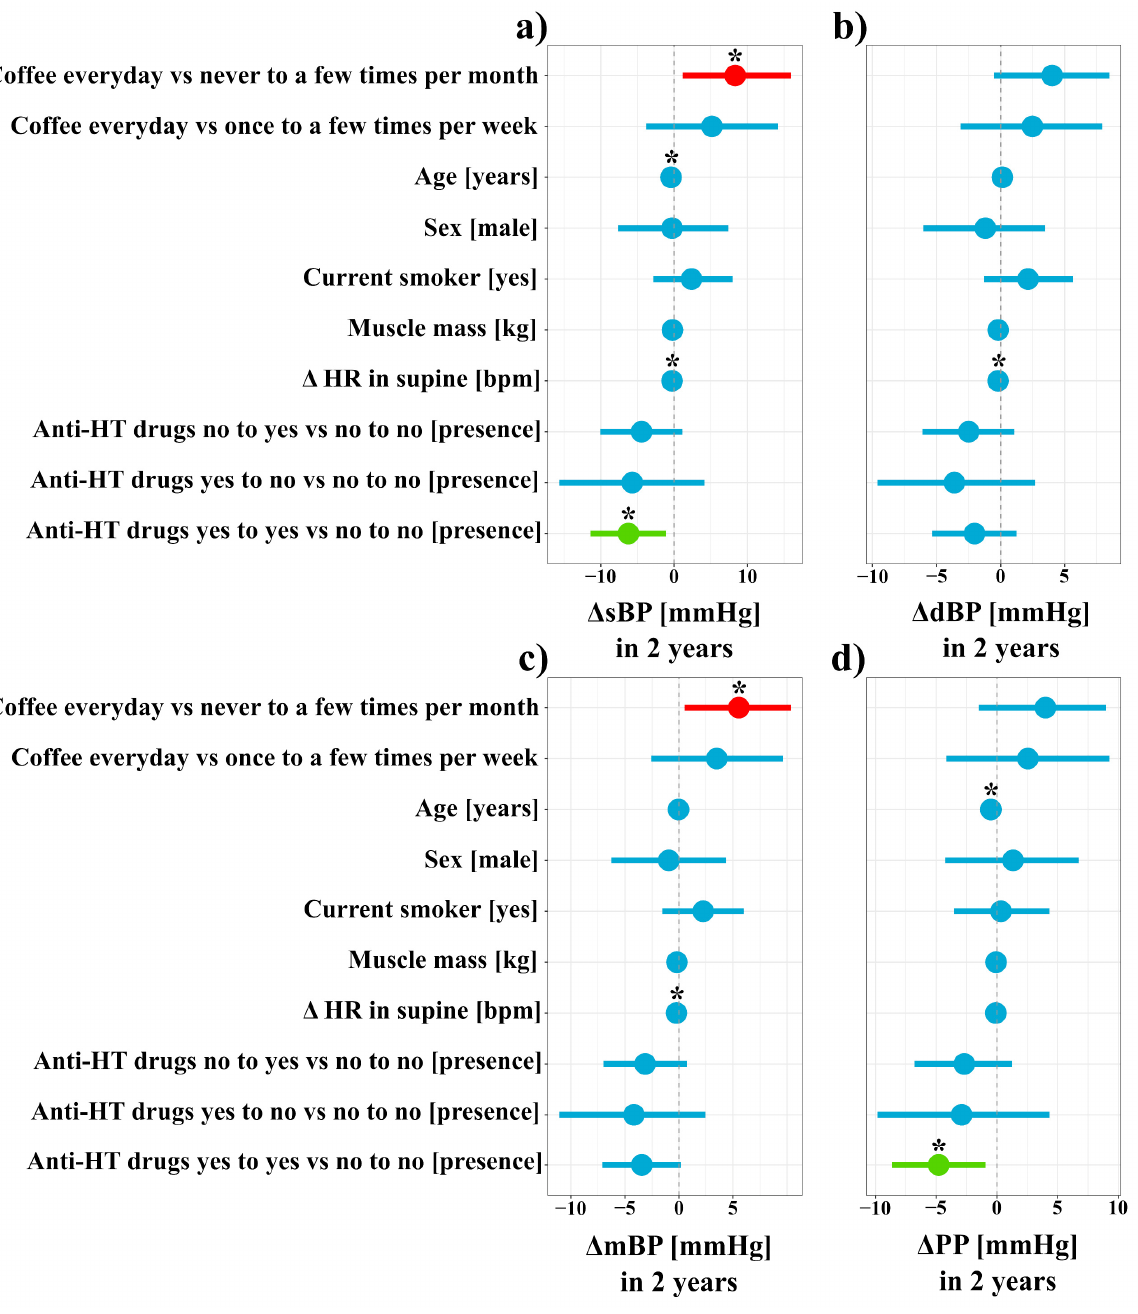
Figure 3. Mixed linear model predicting blood pressure changes. ( a ) change in systolic blood pressure (sBP) before vs. after 2 years, ( b ) change in diastolic blood pressure (dBP) before vs. after 2 years, ( c ) change in mean blood pressure (mBP) before vs. after 2 years, ( d ) change in pulse pressure (PP) before vs. after 2 years. The vertical axis denotes predictors of change in blood pressure, while the horizontal axis illustrates dynamics of blood pressure before vs. after two years. The “0” on the horizontal axis denotes no changes in blood pressure within two years (denoted by a vertical dashed line). Predictors with negative estimates are placed on the left side of the dashed line (factors associated with a decrease in blood pressure after two years). Predictors with positive estimates are placed on the right side of the dashed line. Red horizontal lines illustrate predictors in which both confidence interval values are lower than 0, while blue illustrates predictors in which confidence interval values of estimates cross zero. Green indicate predictors in which both confidence interval values of estimates are greater than 0. “*” mean predictors that are statistically significant ( p < 0.05). “ Δ HR in supine [bpm]” denotes heart rate (HR) in supine position both after two years and before. “Anti-HT drugs no to yes vs. no to no” denotes patients who were not taking antihypertensive drugs during baseline, but started to take after two years in comparison to patients who did not take antihypertensive drugs at either time point. “Anti-HT drugs yes to no vs. no to no” denotes patients who were taking antihypertensive drugs during baseline, but ceased to take them after two years in